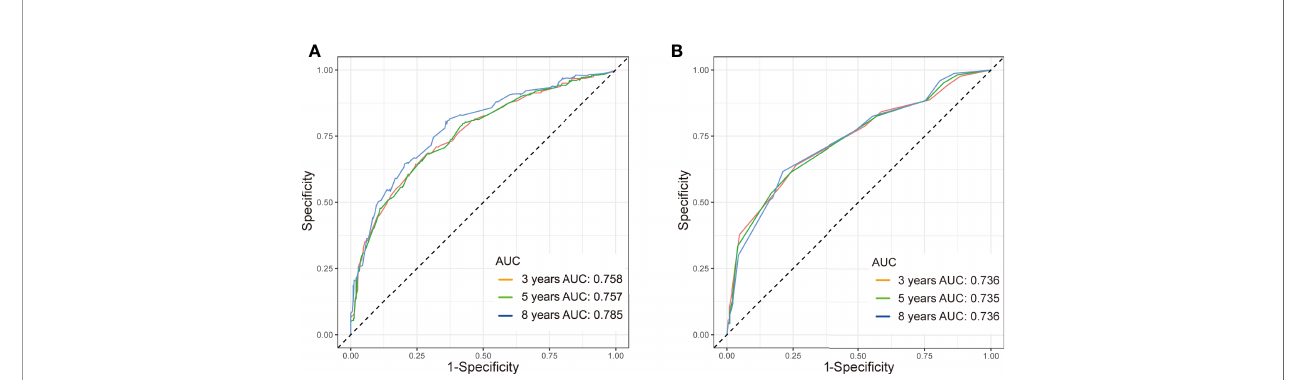
FIGURE 3 | ROC curve with AUC for OS in TN MpBC patients. (A) 3-, 5-, and 8-year OS rate in the training set, (B) 3-, 5-, and 8-year OS rate in the validation set.